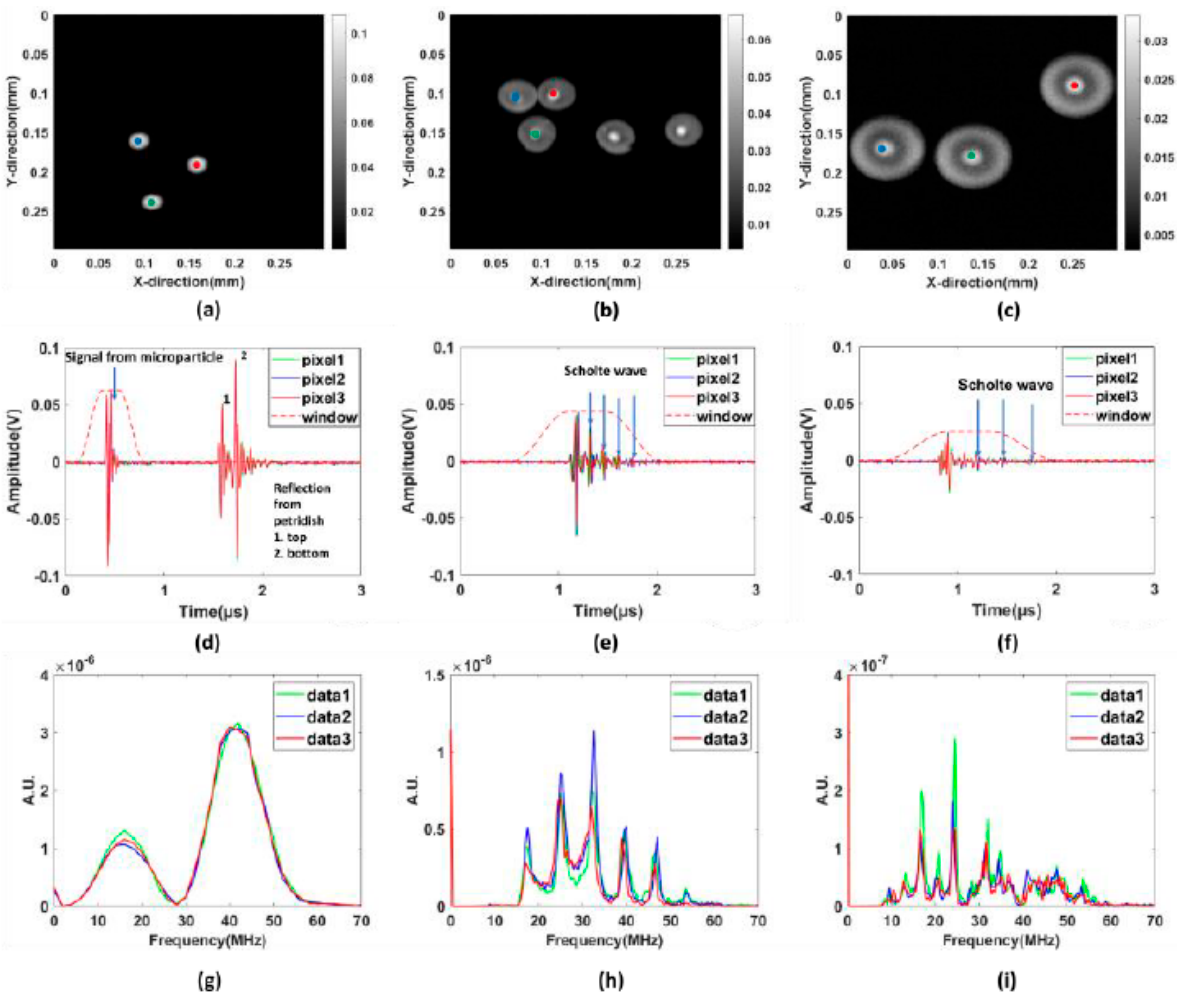
Figure 3. Experimental results for the photoacoustic imaging. Here the upper images show the maximum amplitudes obtained for the 3 particle sizes ( a ) PS20 ( b ) PS40 and ( c ) PS80 over the entire scanning area. Time series for pixels close to the centre of three particles in each image (marked with red, green, and blue dots) are shown with corresponding colours in ( d – f ) for PS20, PS40, and PS80, respectively. The amplitude spectra corresponding to the time series in ( d – f ) are shown in ( g – i ), respectively. For these spectra, the time series were multiplied with the windows shown in ( d – f ) to exclude reflections from the bottom of the Petri dish.